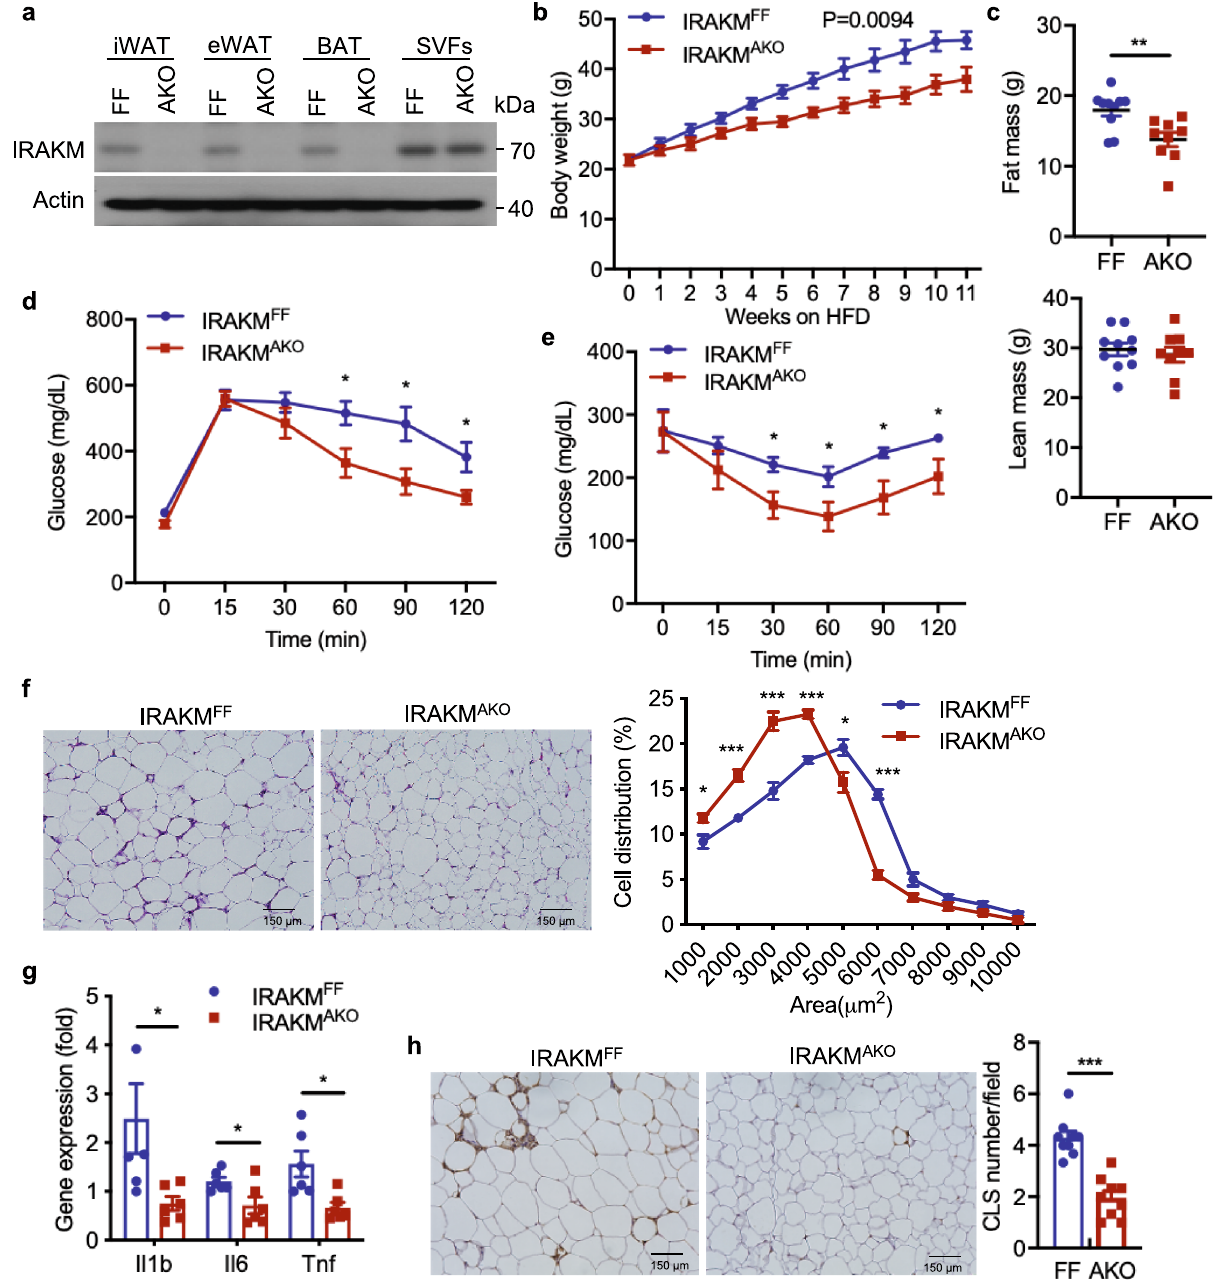
Fig. 1 Adipocyte-speci fi c IRAKM de fi ciency attenuates HFD-induced obesity. a Western blot analysis of IRAKM expression in mature adipocytes and stromal vascular fractions (SVFs) of iWAT, eWAT, and BAT from IRAKM F/F and IRAKM AKO mice. Data are representative of two independent experiments. b Body weight of IRAKM F/F and IRAKM AKO mice fed with high-fat diet (HFD) for 11 weeks ( n = 6 males per group). c EchoMRI analysis of IRAKM F/F and IRAKM AKO mice after HFD feeding ( n = 10 for IRAKM F/F mice; n = 9 for IRAKM AKO mice; P = 0.0058.). d Glucose tolerance test (GTT) were analyzed in HFD-fed IRAKM F/F and IRAKM AKO mice ( n = 6 mice for each group; from left to right: P = 0.023, 0.021, 0.034). e Insulin tolerance test (ITT) were analyzed in HFD-fed IRAKM F/F and IRAKM AKO mice ( n = 7 for IRAKM F/F mice; n = 6 for IRAKM AKO mice; from left to right: P = 0.017, 0.039, 0.018, 0.037). f Representative H&E staining of iWAT sections from HFD-fed IRAKM F/F and IRAKM AKO mice. Adipocyte cell size distributions were analyzed in different sections from fi ve mice ( n = 5 for IRAKM F/F mice; n = 4 for IRAKM AKO mice; 3 sections per mouse; from left to right: P = 0.029, 0.00029, 0.0008, 0.00006, 0.027, 0.000006). g In fl ammatory genes expression in iWAT of HFD-fed IRAKM F/F and IRAKM AKO mice were analyzed by real-time PCR ( n = 6; from left to right: P = 0.038, 0.028, 0.011). h Representative Mac2 staining of iWAT sections from HFD-fed mice. Numbers of crown-like structures (CLS) were quanti fi ed via Mac2 staining in different sections ( n = 3 mice per group; 3 views per slide and 3 sections per mouse; n = 9 sections; P = 0.000009). Statistical signi fi cance was determined by two-way ANOVA followed by post hoc analysis ( b ) or two-tailed Student ’ s t -test ( c – h ). * P < 0.05. ** P < 0.01. All data represent mean ± s.e.m. Source data are provided as the Source data fi le.